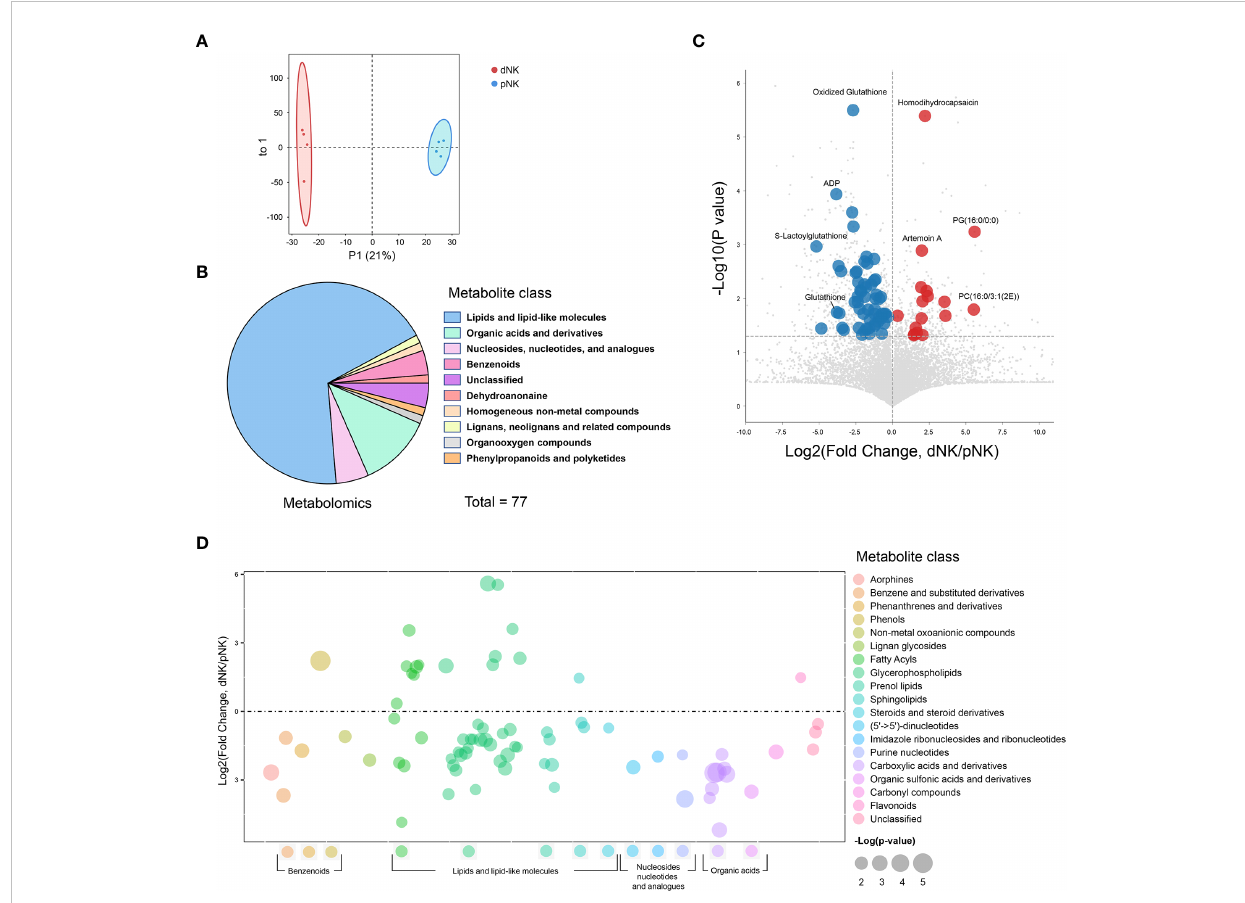
FIGURE 2 Metabolomics pro fi le of dNK and pNK cells. (A) OPLS-DA score plots of metabolomics data. Each symbol represents one donor (n=4). (B) Pie chart showing differential metabolites of different classes. Different colors indicate different classes. (C) Volcano diagrams showing all of the identi fi ed metabolites from metabolomics data. The x-axis and y-axis are based on the fold change (FC) and p-values, respectively. Each dot represents a metabolite. Signi fi cantly upregulated, downregulated (VIP > 1, p value < 0.05, FC > 1 or < 1), and unchanged DEPs are colored in red, blue, and gray, respectively. The horizontal line denotes a p-value cutoff of 0.05. (D) Bubble plot of log2(fold change) in abundance of metabolite species in dNK relative to pNK cells (ctrl). Values are shown as log2(fold change) relative to pNK cells. Each dot represents a metabolite species. Color-coded per metabolite class. Dot size indicates signi fi cance. The horizontal line denotes FC of